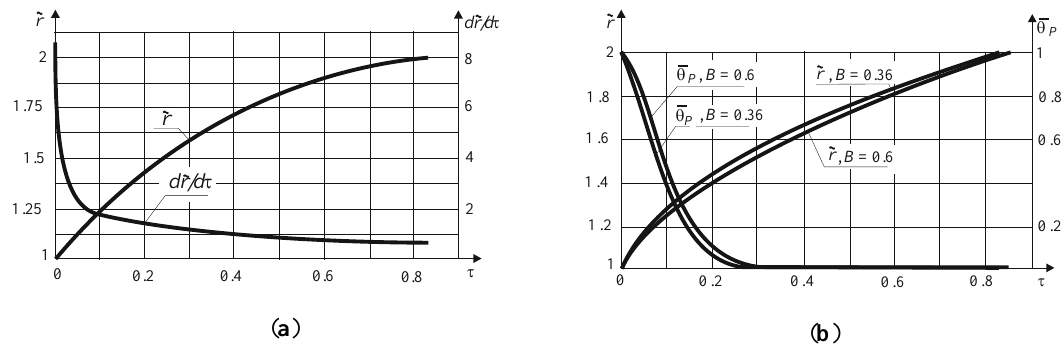
Figure 4. Numerical results for system (14)–(15) with parameters 𝑆𝑡𝑒 = 0.112, 𝑠 = 0.5, 𝐵𝑖 𝐶𝑂𝑁 = 10, 𝐵𝑖 𝐶 = 177, 𝑘̃ = 1,𝑎̃ = 0.886) for a heated liquid: ( a ) the dependence of the position of the solidification front and the velocity of the solidification on time ( 𝐵 = 0.36 ) and ( b ) the dependence of the average temperature and the position of the solidification front on time ( 𝐵 = 0.36 and 𝐵 = 0.6 ).